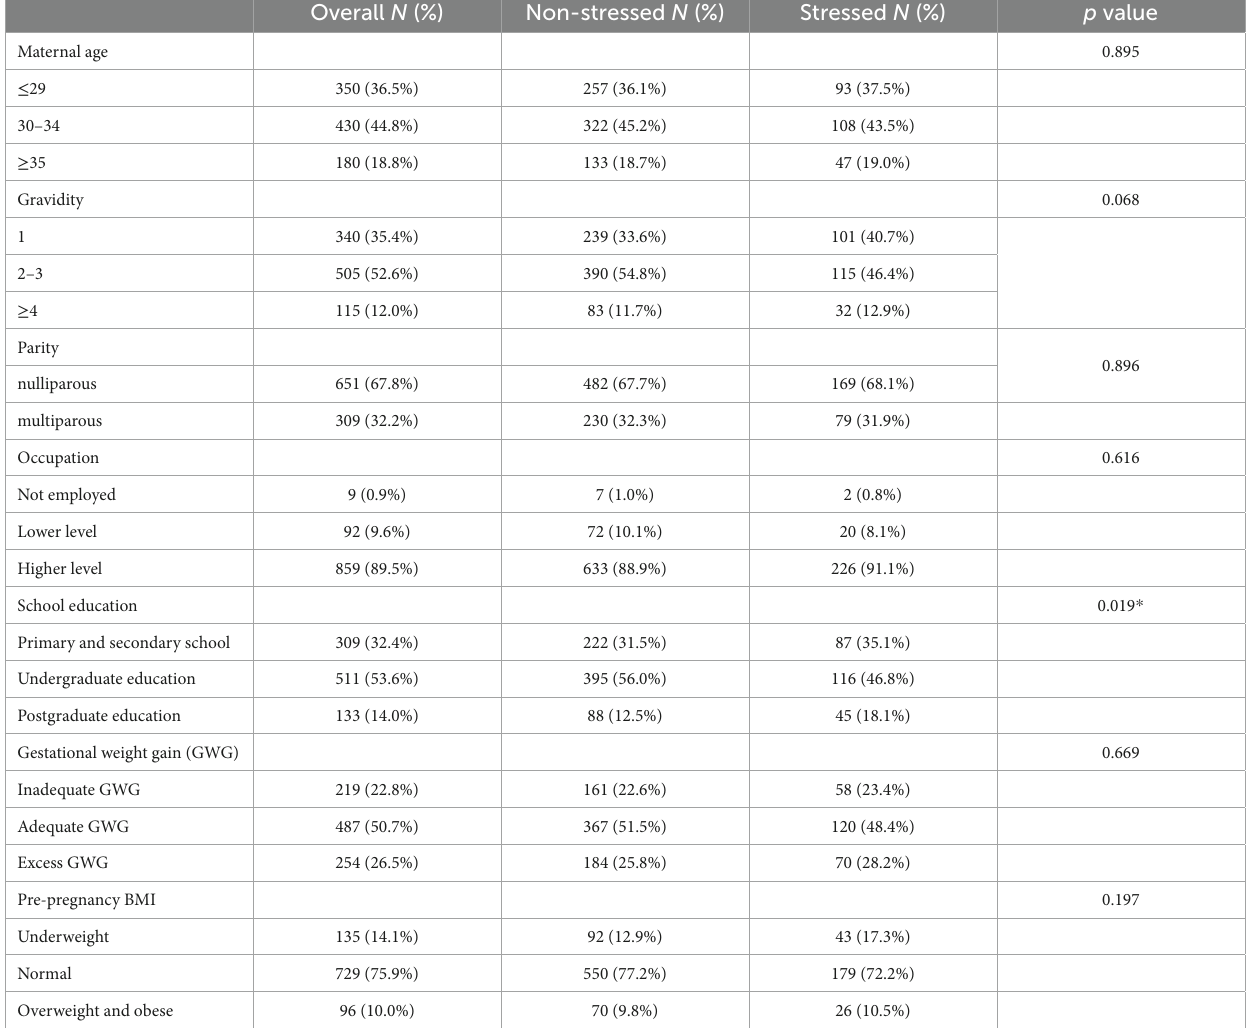
TABLE 1 Sociodemographic and obstetric characteristics of non-stressed and stressed